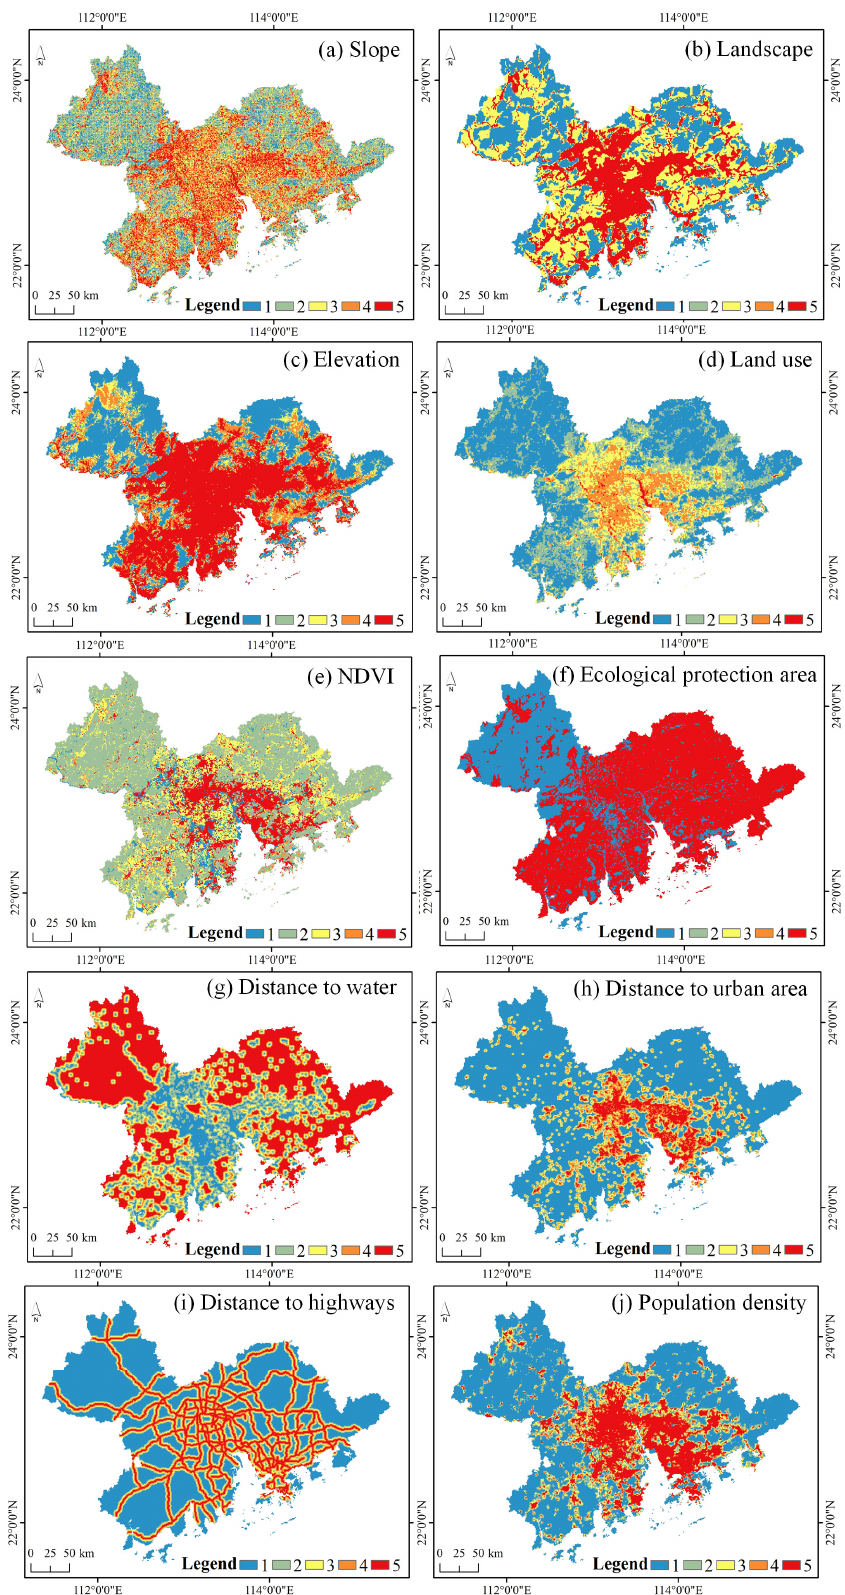
Figure 3. Spatial distribution of resistance factors after grading.